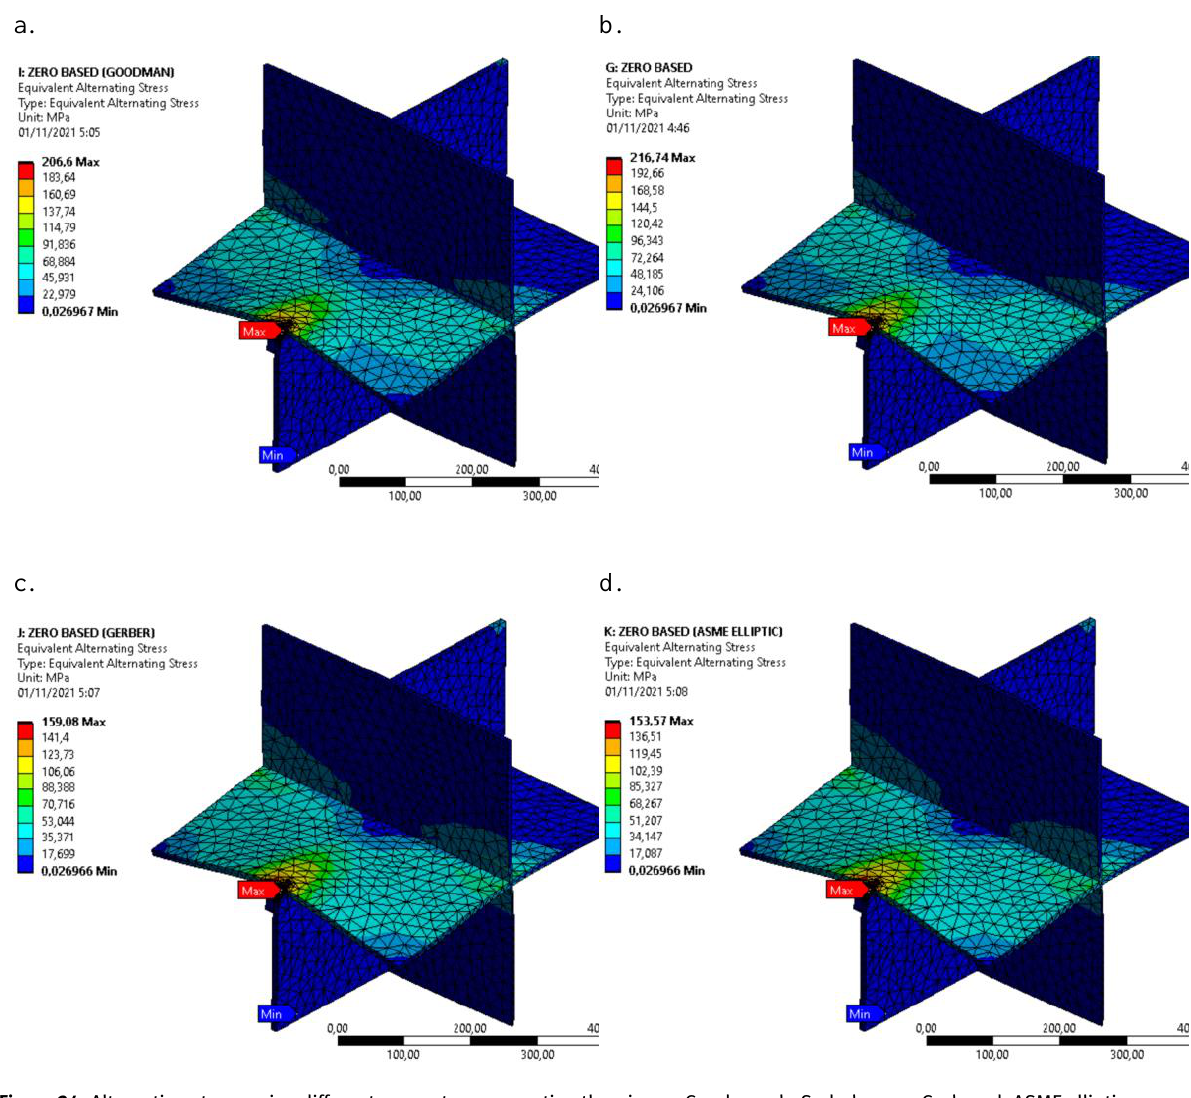
values are close to the results of the correction by the Figure 24. Alternating Stress using Different Mean Stress Correction Theories: a. Goodman; b. Soderberg; c. Gerber; d. ASME Elliptic